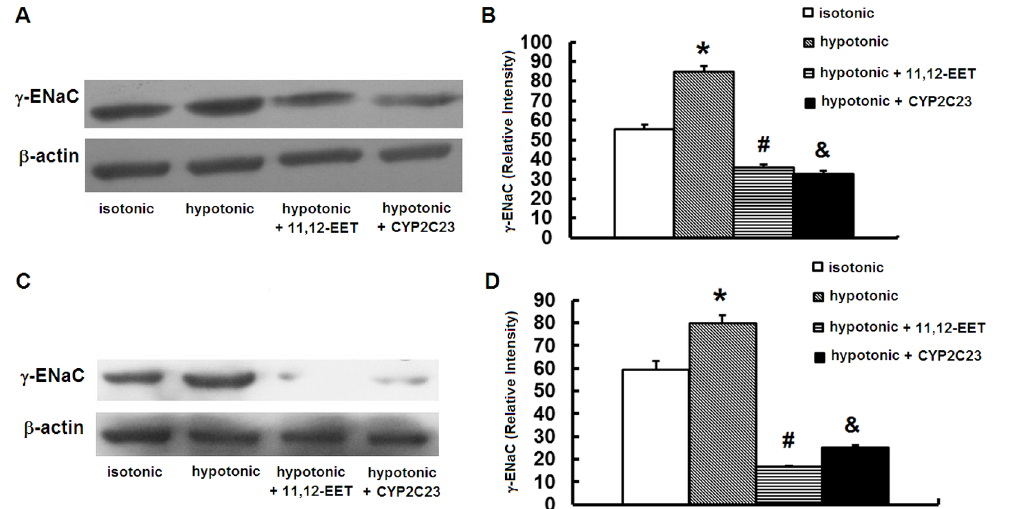
Figure 5. Protein c -ENaC detected by western blot. EETs and CYP2C23 transfection decreased apoptosis of IMCD cells induced by hypotonic stress via c -ENaC. (A)(B) EETs or Ad-CMV-CYP2C23-EGFP transfection inhibited the up-regulation of c -ENaC induced by 12 h hypotonic stress. (C) (D) EETs or Ad-CMV-CYP2C23-EGFP transfection inhibited the up-regulation of c -ENaC induced by 24 h hypotonic stress. (A) (C) Representative blots. (B) (D) Densitometric analysis. *, P , 0.05 compared with isotonic group. # , P , 0.05 compared with hypotonic group. &, P , 0.05 compared with hypotonic group. Error bars represent the standard deviations based on three independent replicates.